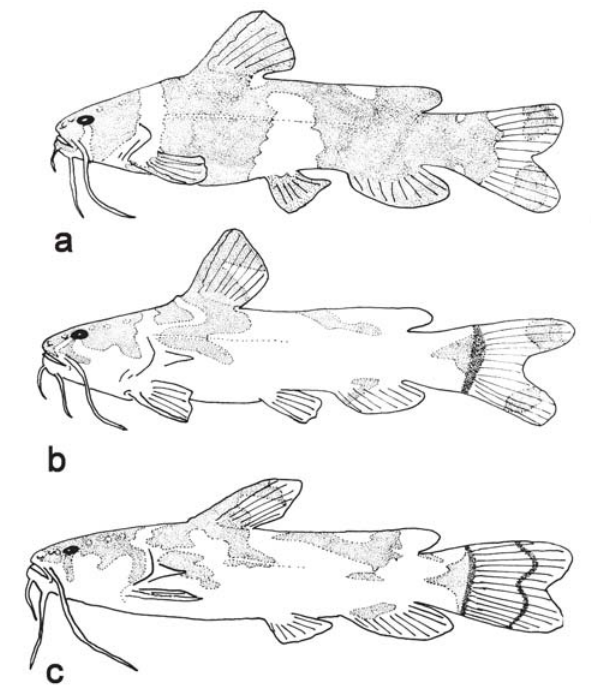
Fig. 11. Schematic drawing illustrating the general coloration pattern in Microglanis species found in the Eastern Atlantic Basin. a. Microglanis nigripinnis ; b. M . parahybae ; c. M . pataxo